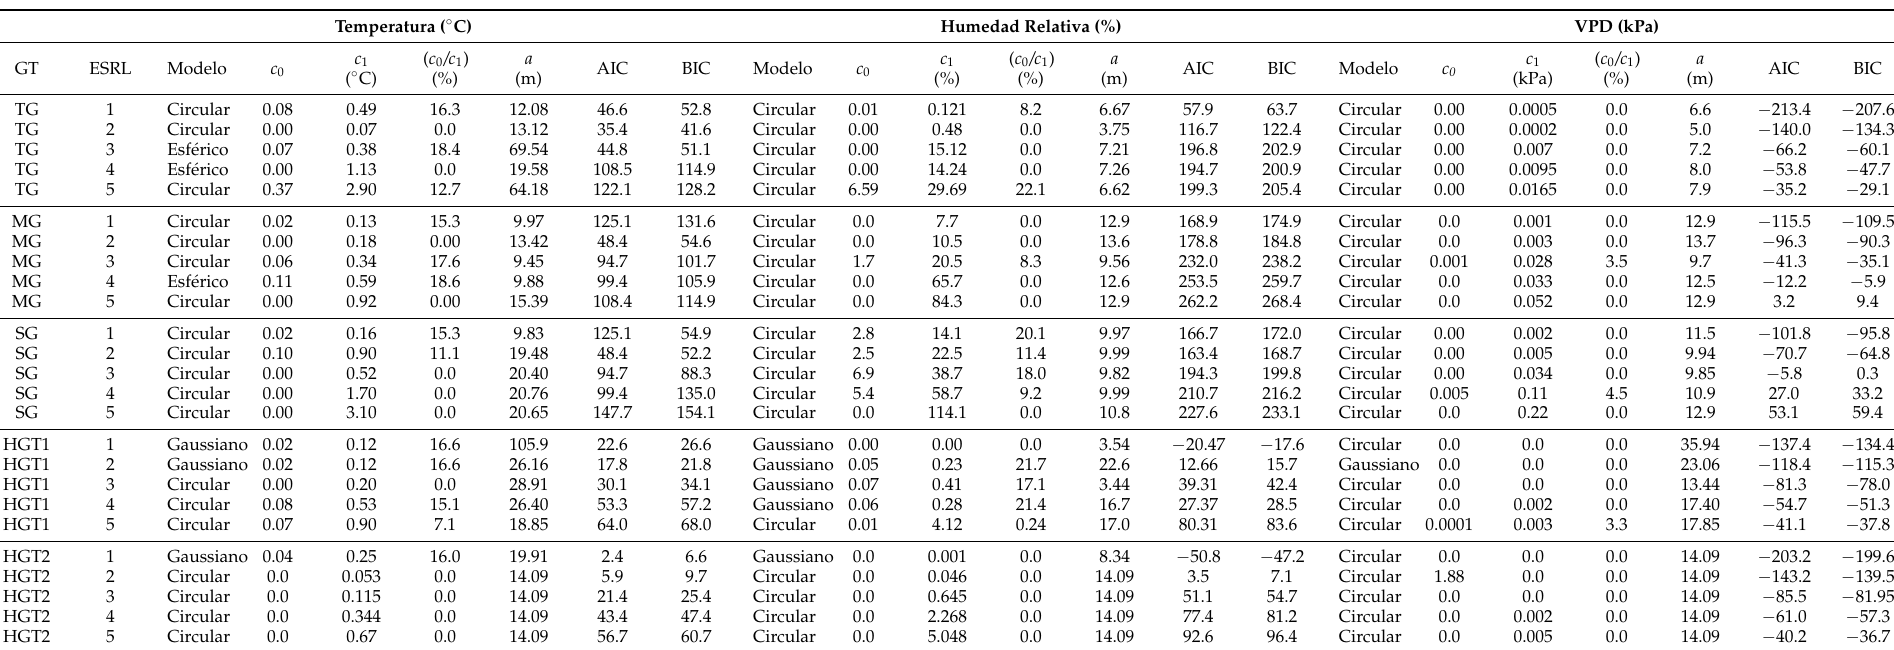
Table 9. Model parameters of the selected theoretical semivariograms and their quality of fit measures (Akaike Information Criteria; AIC, and Bayesian; BIC) for the temperature, relative humidity and VPD datasets of the five greenhouses